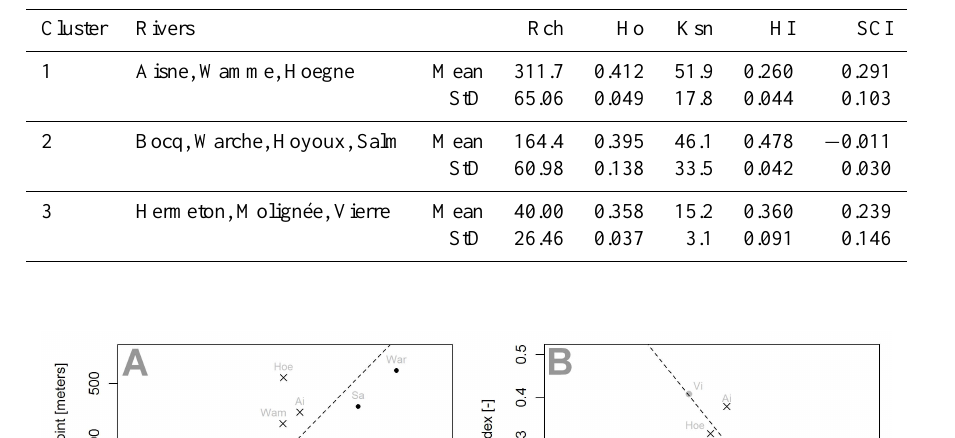
Table 2. Clusters characteristics (values of mean and standard deviation of the parameters).